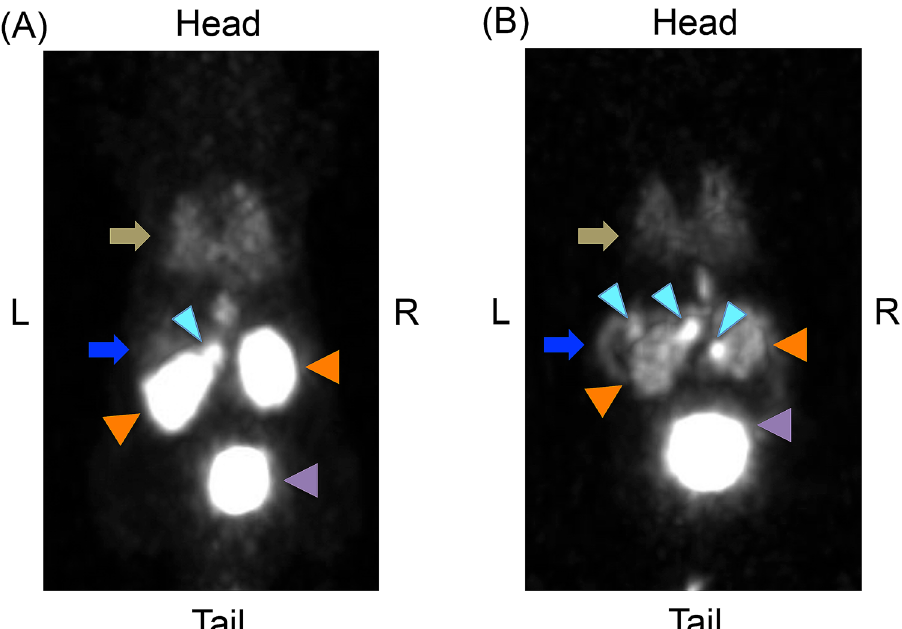
Figure 3. Representative maximum intensity projection PET images of [ 18 F]FB(ePEG12)12-exendin-4. Maximum intensity projection (MIP) PET images of [ 18 F]FB(ePEG12)12-exendin-4 in representative Pdx1- Cre;Trp53 R172H ;Rb f/f mouse. MIP images were reconstructed at ( A ) 30-min post-injection and ( B ) 120-min post-injection of [ 18 F]FB(ePEG12)12-exendin-4. MIP images indicated high tumor uptakes, sustained pancreas uptake and rapid kidney clearance of the probe. The signals from the tumors are represented by light blue arrowheads. Signals from the kidney, orange arrowheads; signals from bladder, mauve arrowheads; signals from the pancreas, blue arrows; signals from the lung, yellow–brown arrows. L, left; R,